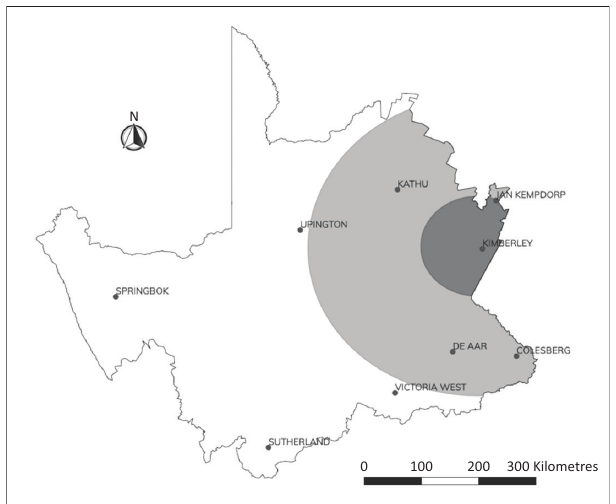
FIGURE 5: Map of the Northern Cape province illustrating the location of Kimberley and other major towns within the province. The dark grey and light grey areas represent distances of 100 km and 300 km,